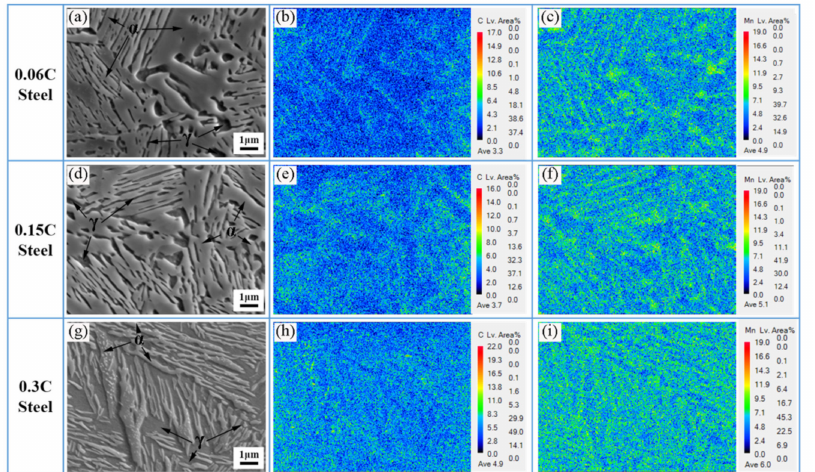
Figure 9. SEM micrograph and corresponding C and Mn concentrations distribution of 0.06C